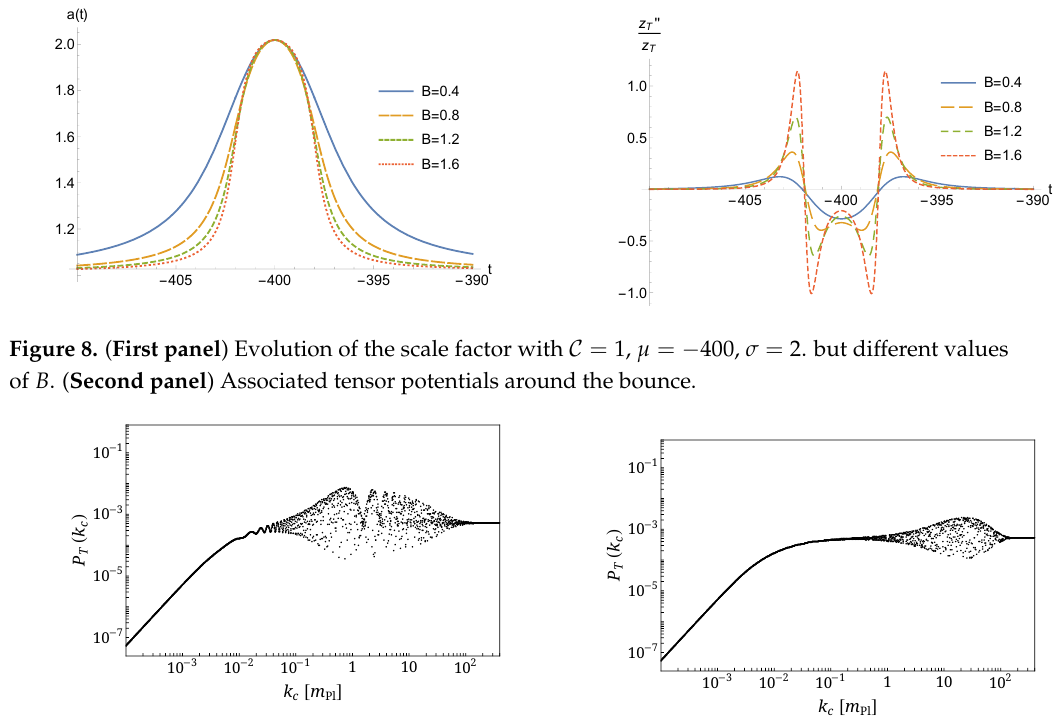
Figure 9. ( First panel ) Primordial tensor power spectrum obtained with a steep bounce characterized by C = 1, µ = − 400, σ = 2, and B = 40. ( Second panel ) Spectrum with a narrower bounce (than in the first panel): σ =